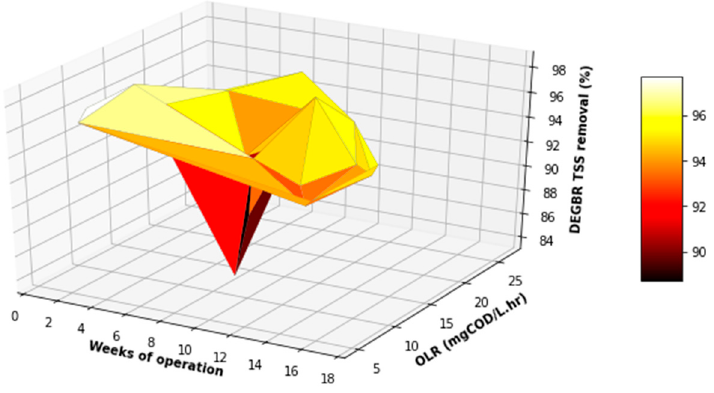
Figure 13. Performance of the DEGBR with respect to the TSS removal under varying OLRs.